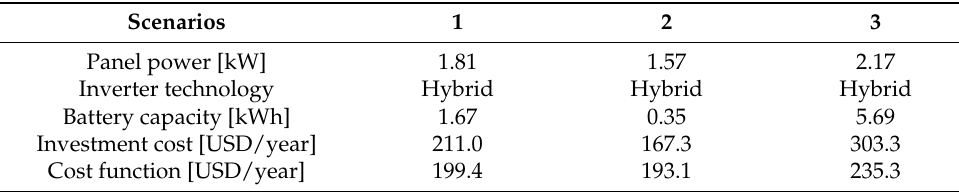
Table 9. Deterministic results for each scenario of the one-client microgrid (Case 1).